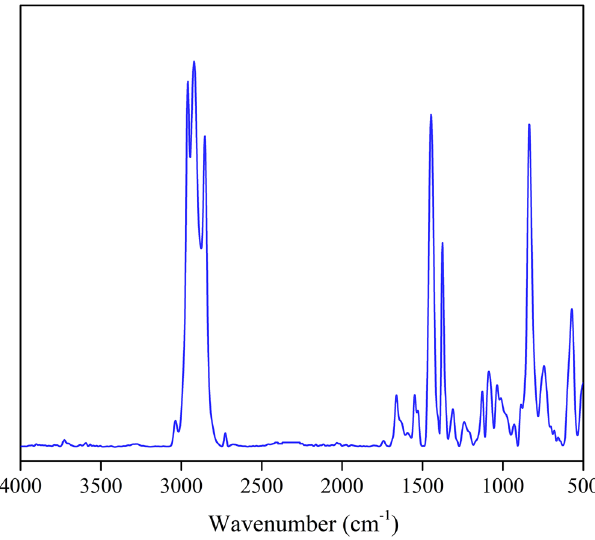
Figure 1. ATR–FTIR spectrum of the control sample: 3015–2970 cm −1 attribute to C–H stretching of CH 3 and CH 2 , 1672 cm −1 attributes to C=C stretching, 935–1171 cm −1 attribute to C–S stretching, and 840 cm −1 attributes to C=C wagging 9